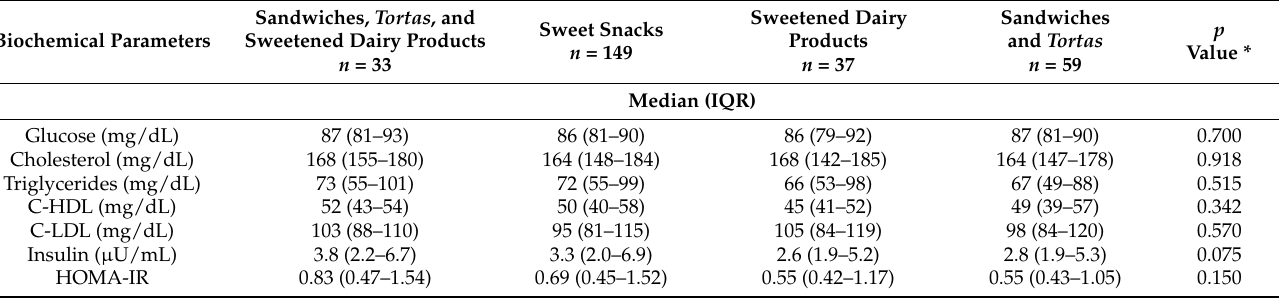
Table 4. Metabolic parameters according to dietary